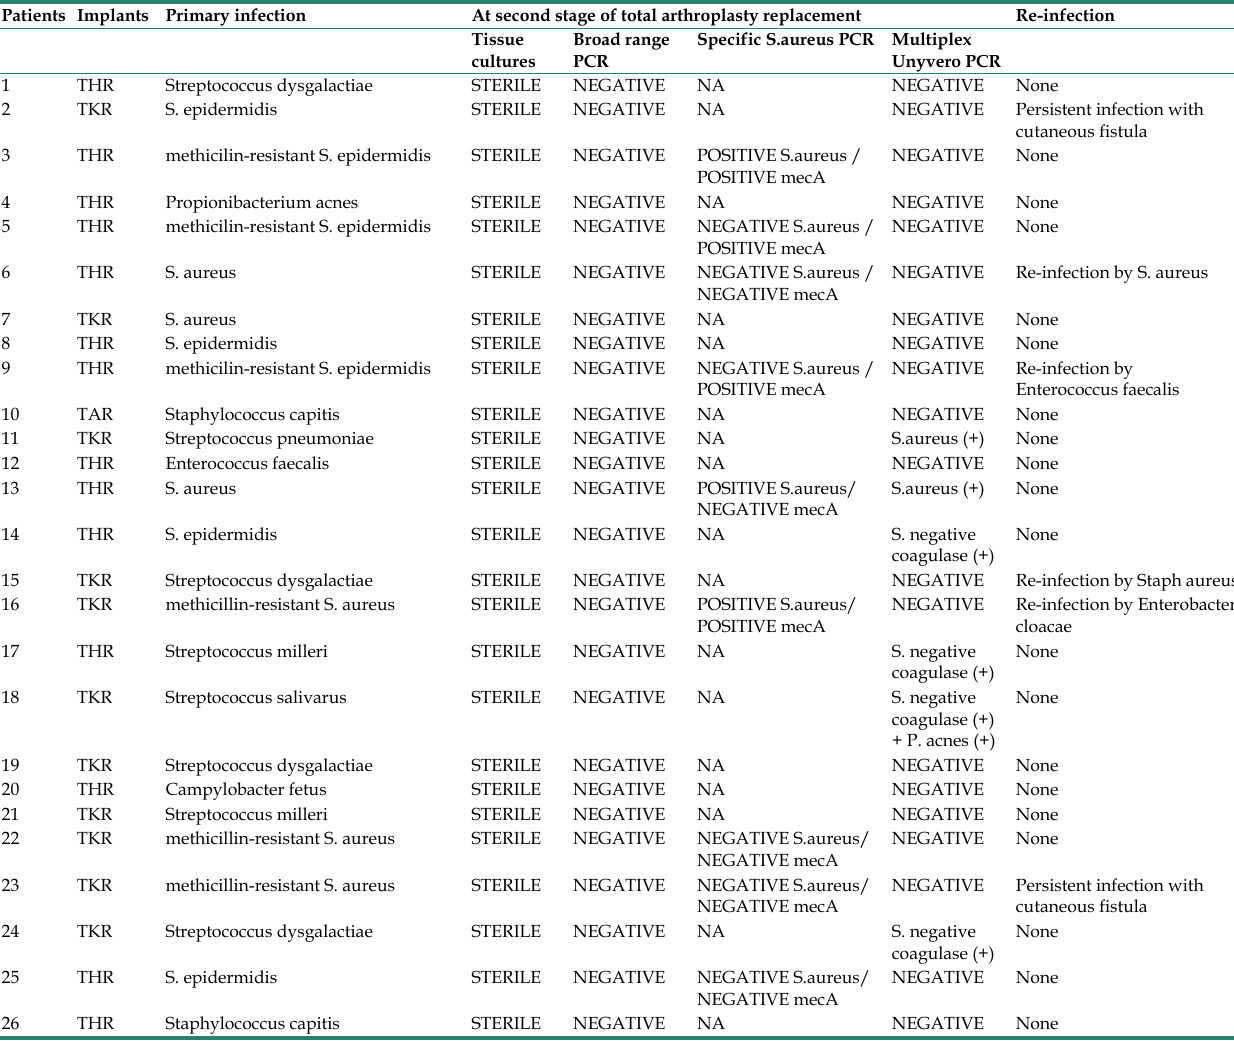
Table 1. Results of PCR analysis Patients Implants Primary